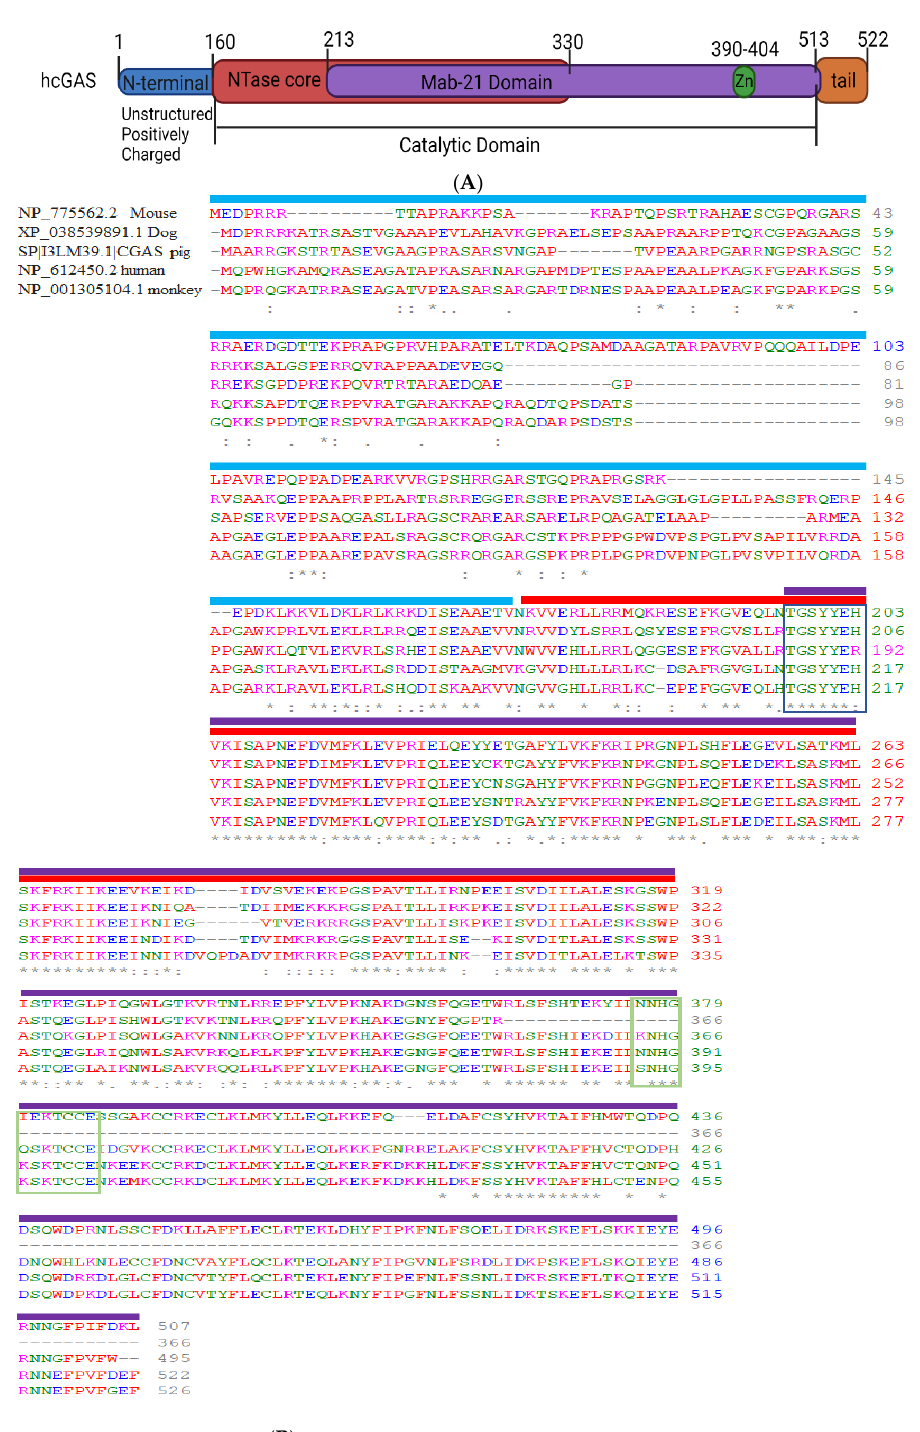
Figure 1. ( A ) Sequence structure of cGAS showing different domains. ( B ) Multiple sequence alignment of truncated amino acid sequences of (>NP_612450.2 cGAS-HUMAN, >NP_775562.2 cGAS-MOUSE, >NP_001305104.1 cGAS-MONKEY, >sp|I3LM39.1|CGAS-PIG, >XP_038539891.1 cGAS-DOG using Clustal OMEGA. cGAS protein sequence alignment from different mammalian species showed highly disorganized N terminal (~1–160 aa) whereas the C terminal of cGAS (161–370 aa) is more than 70% conserved among different mammalian species. The Blue box indicate the most conserved DNA binding region and the green box indicate the conserved Zinc Finger motif.